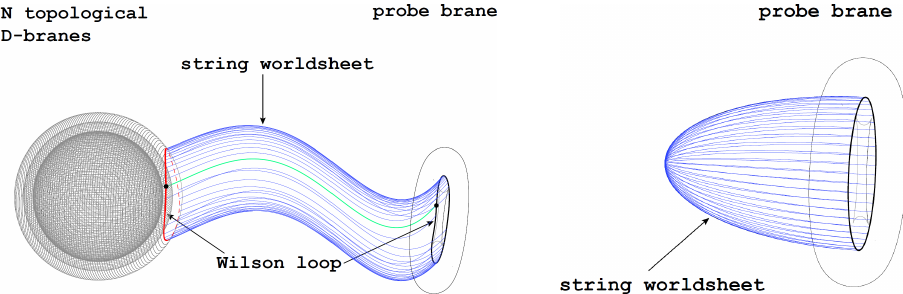
Figure 21 . Duality between Wilson loop and worldsheet in topological string. There is an S 3 at asymptotic infinity that has been omitted from the picture [26,